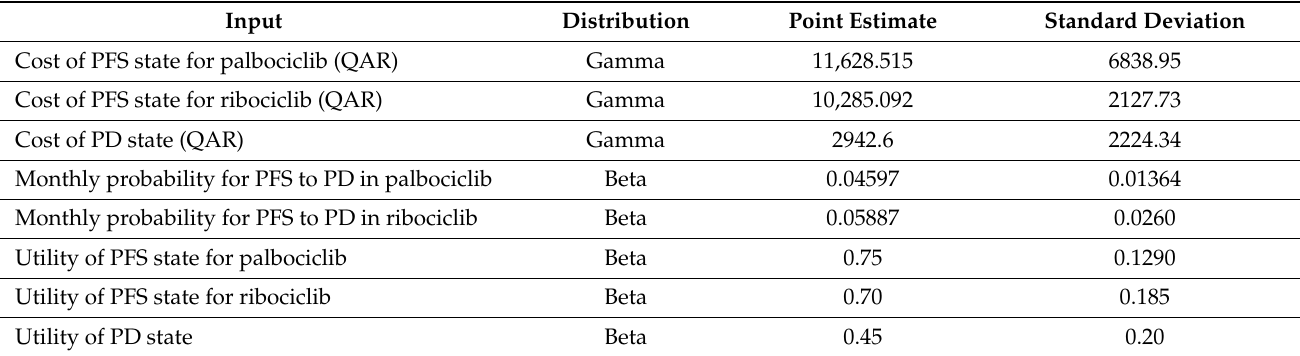
Table 3. Probabilistic sensitivity analysis (PSA)